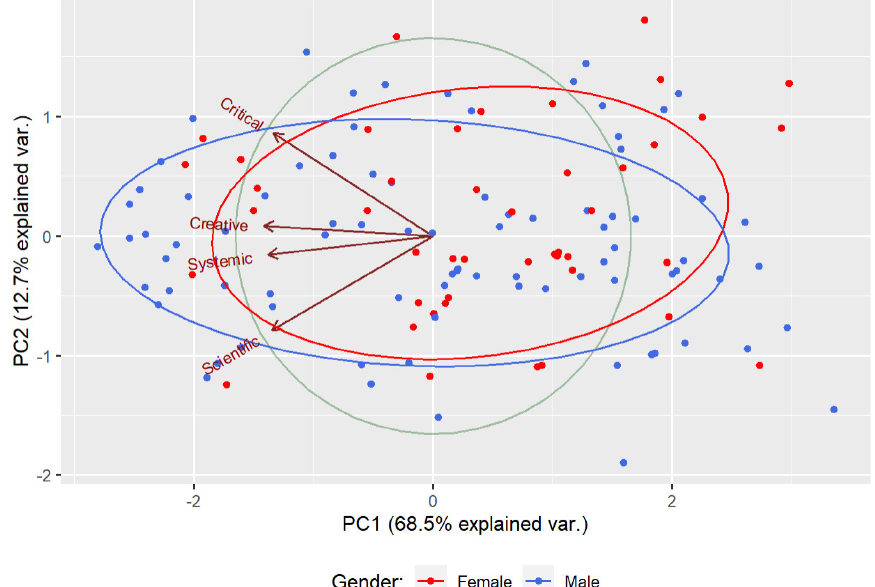
Fig. 9. Complex thinking: principal omponent Biplot explaining 81.20% of the data variability. Biplot of the form (α =